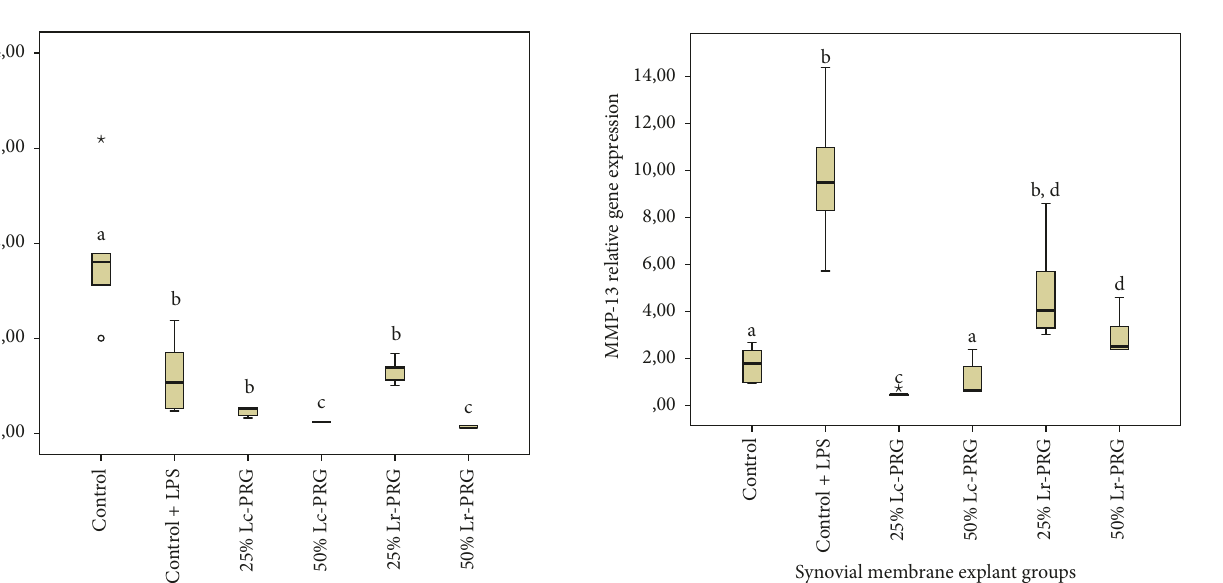
Figure 2: Box plot of median relative nuclear factor kappa B (NF 𝜅 B) gene expression. a–c Lowercase letters denote significant differences (𝑝 > 0.05) between synovial membrane explant (SME) groups treated with leukoconcentrated platelet-rich gel (Lc-PRG) and leukoreduced platelet-rich gel (Lr-PRG) supernatants at different concentrations (25 and 50%). Groups with the same lowercase letter are not significantly different. ∘ denotes an outlier value, whereas ⋆ denotes extreme value; both symbols show nonparametric data.